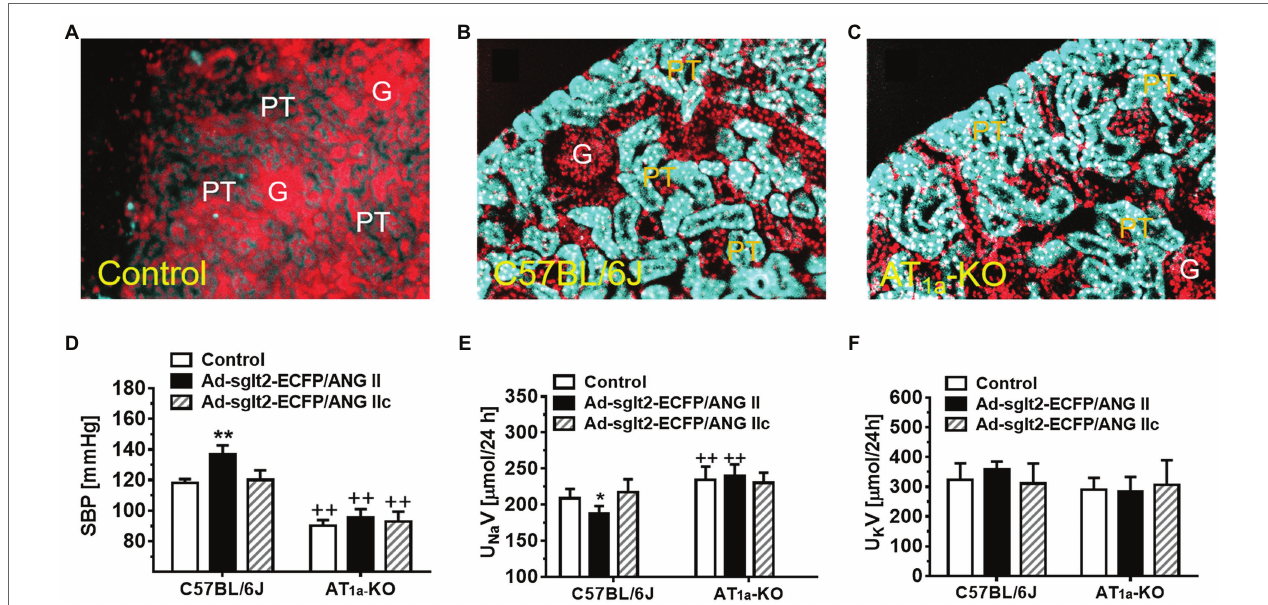
FIGURE 1 | Overexpression of intracellular ECFP/ANG II selectively in the proximal tubule of the kidney in C57BL/6J or AT 1a -KO mice and its effects on systolic blood pressure and 24 h urinary sodium (U Na V) and potassium excretion (U K V). (A) A representative control C57BL/6 J kidney showing a low level of autofluorescence in the cortex. (B) A representative control C57BL/6 J kidney showing overexpression of ECFP/ANG II selectively in the proximal tubule of the superficial cortex in blue-green color. (C) A representative AT 1a -KO mouse kidney also showing overexpression of ECFP/ANG II selectively in the proximal tubule. Red represents DAPI-stained nuclei in the cortex after conversion from blue color. (D) Effect on systolic blood pressure. (E) Effect on U Na V. (F) Effect on U K V. ** p < 0.01 vs. control, whereas ++ p < 0.01 vs. ECFP/ANG II overexpression. N = 6–8 for each group. Reproduced with permission (Zhuo et al.,